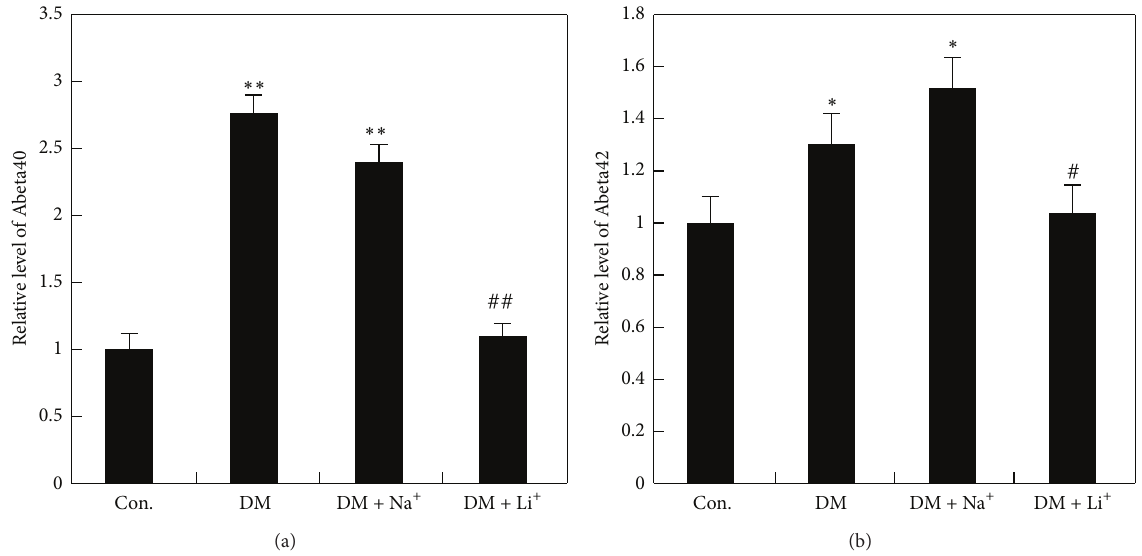
Figure 4: Production of A 𝛽 40 (a) and A 𝛽 42 (b) generation. STZ treatment increased A 𝛽 40 and A 𝛽 42 production significantly and LiCl could reverse the change induced by STZ treatment. ∗ 𝑃 < 0.05 and ∗∗ 𝑃 < 0.01 versus control group, # 𝑃 < 0.05 and ## 𝑃 < 0.01 versus DM group.